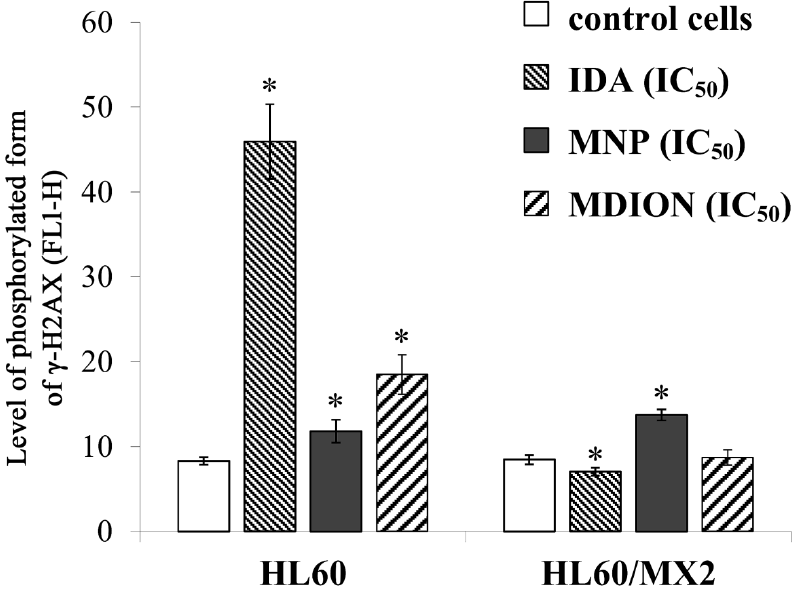
Figure 7. The DSB formation in sensitive HL60 and resistant HL60/MX2 leukaemia cells treated with idarubicin (IDA; positive control), MNP, and MDION. The cells were incubated at 37 ◦ C with studied compounds used at IC 50 (in the case of IDA, at 9.5 µ M for HL60 cells and at 19.0 µ M for HL60/MX2 cells, in the case of MNP, at 24.3 µ M for HL60 cells and at 20.5 µ M for HL60/MX2 cells, in the case of MDION, at 80.5 µ M for HL60 cells and at 95.5 µ M for HL60/MX2 cells) for 24 h. AlexaFluor 488-conjugated monoclonal antibody staining of the phosphorylated form of histone γ - H2AX reflecting the level of DSB damage of cellular DNA was done for control and cell samples treated with studied compounds at IC 50 . The experimental procedure for performing anti- γ -H2AX labelling is described in detail in the Materials and methods section. The green fluorescence FL1-H of 5 × 10 3 single events per sample was measured with the use of a laser beam at 530 ± 30 nm (λex = 488 nm). The level of the phosphorylated form of γ -H2AX was determined by recording the FL1-H values reflecting the signal of AlexaFluor 488 conjugated to the γ -anti-H2AX antibody. The data represent the mean ± SD values of three independent experiments (made in duplicate). The significance level of the differences observed ( Student’s t -test) between values found for cells treated with IDA, MNP, or MDION at IC 50 , respectively, (* p < 0.05), compared with values found for control cells.